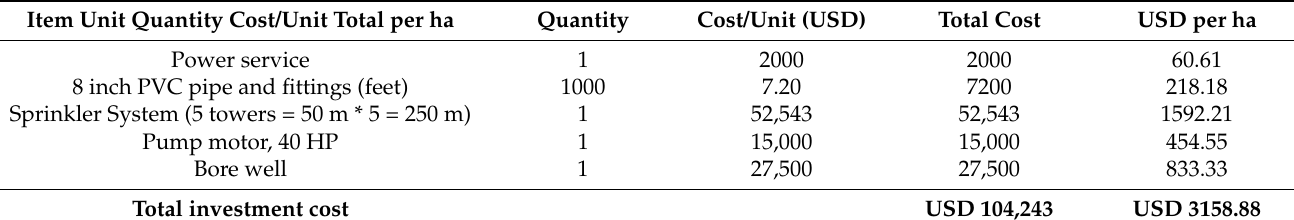
Table 1. Infrastructure and Initial Investment